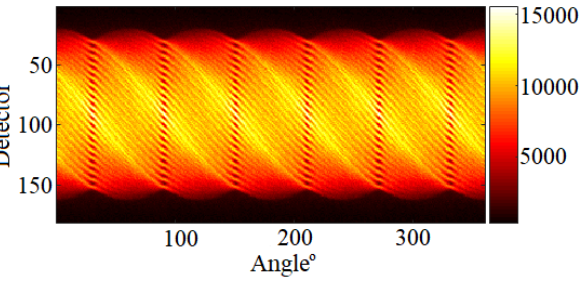
Figure 10. Simulated sinogram of Case “1”. The colour scale represents the detected photon